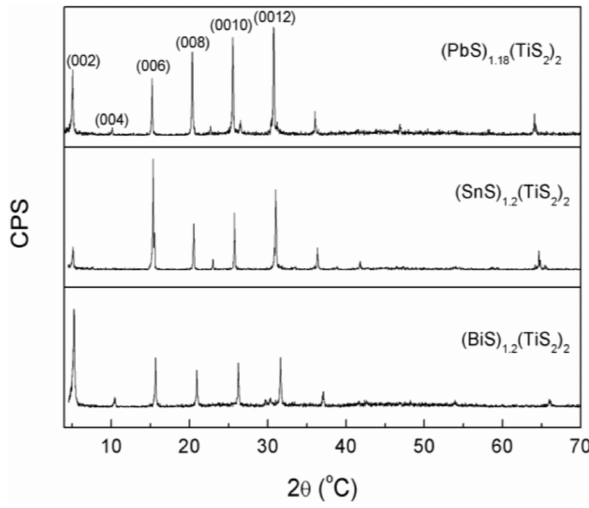
Figure 11: XRD patterns of (BiS) 1.2 (TiS 2 ) 2 , (SnS) 1.2 (TiS 2 ) 2 and (PbS) 1.18 (TiS 2 ) 2 . Reproduced from Ref.